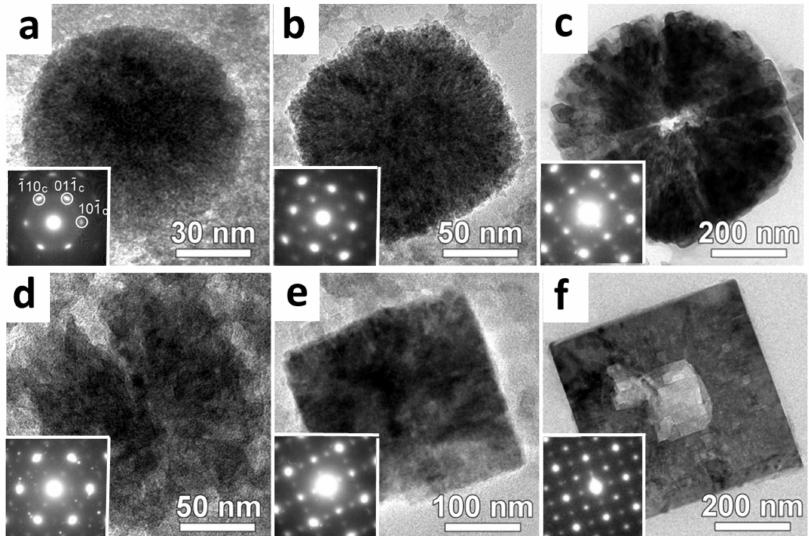
Figure 4. TEM images and corresponding SAED patterns of particles during growth of CaTiO 3 obtained from the water-free system with different crystal growth times: ( a ) 1, ( b ) 2, and ( c ) 5 h. TEM images and SAED patterns obtained from the system containing 1.25 vol % water with different crystal growth times: ( d ) 1, ( e ) 2, and ( f ) 5 h. Reprinted with permission from [35]. Copyright 2010, American Chemical